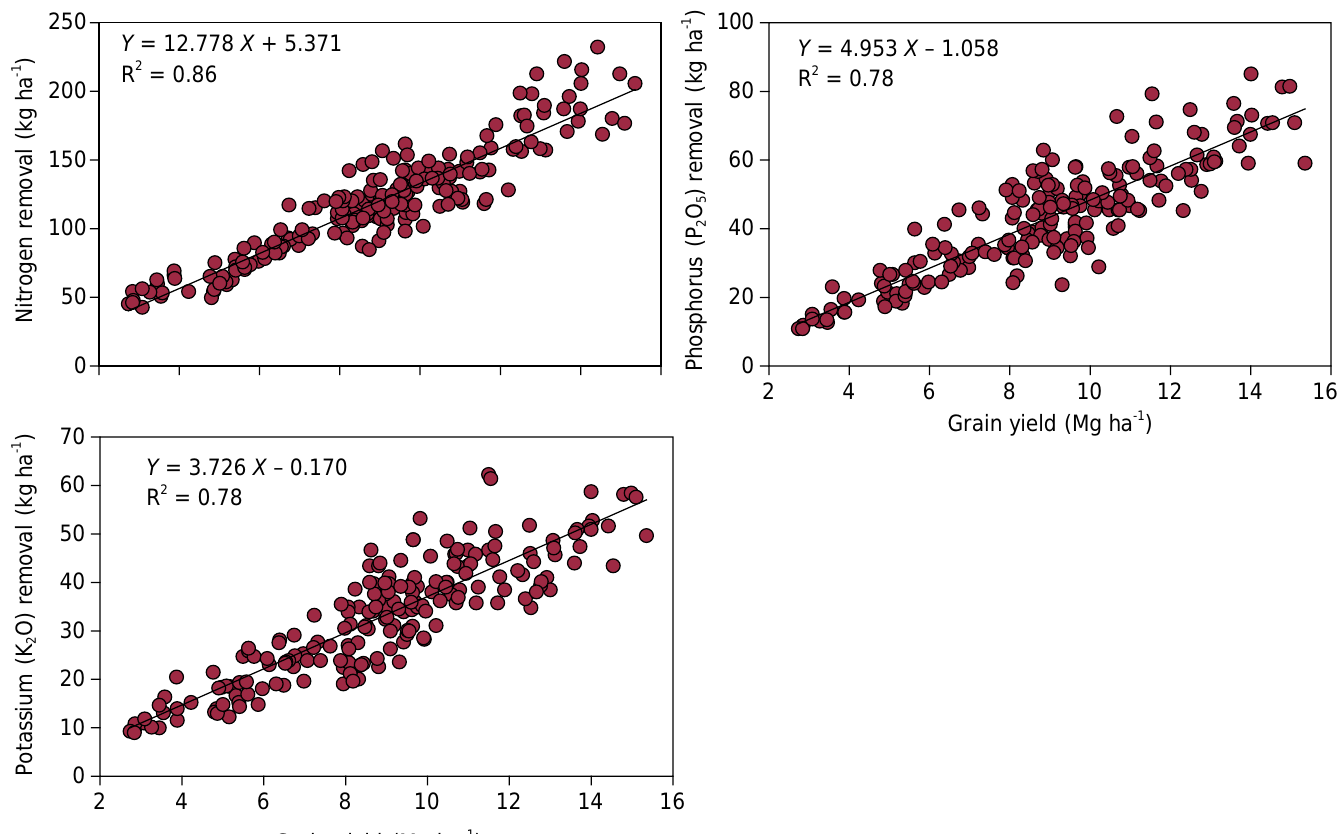
Figure 2. Nitrogen, phosphorus (P 2 O 5 ), and potassium (K 2 O) removal, respectively, related to corn grain yield.